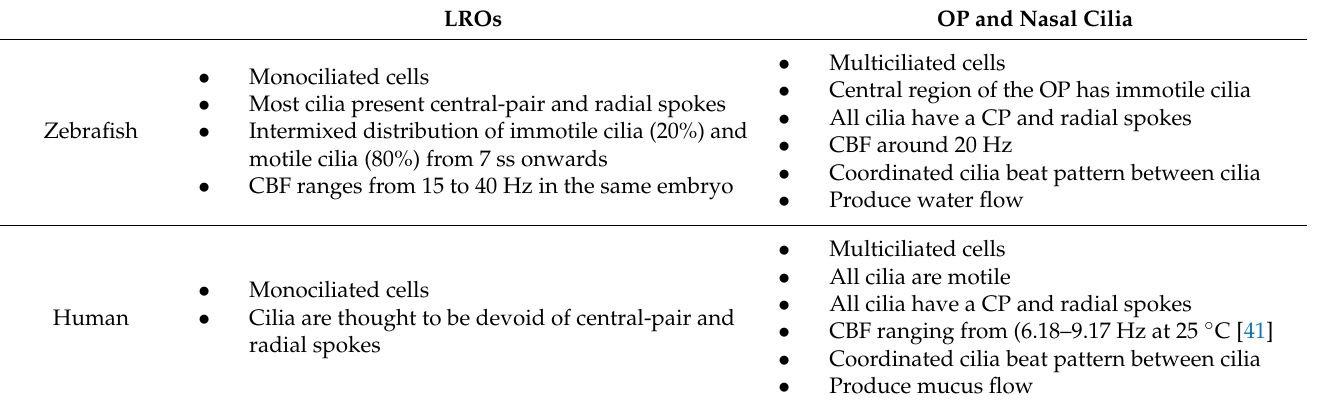
Table 3. Comparison between zebrafish and human cilia from the LRO and from the OP/nasal cilia. LROs OP and Nasal Cilia